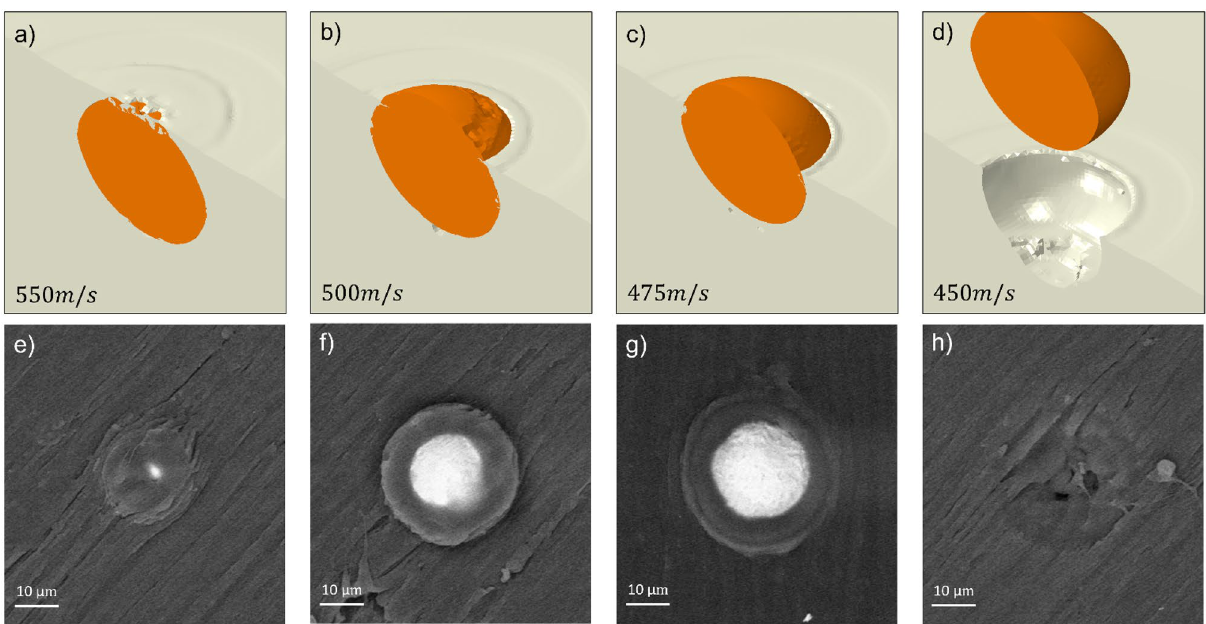
Figure 9. The effect of particle velocity fluctuations on the extent of particle bonding ( a ) 550 m / s ( b ) 500 m /